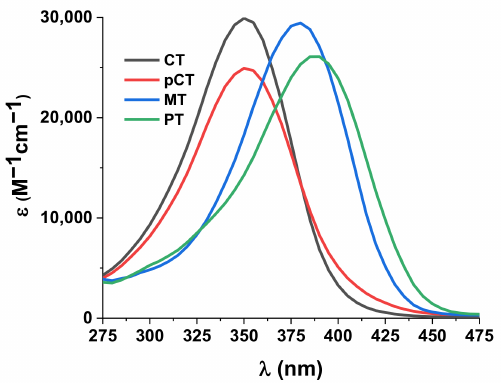
Figure 4. UV − Vis absorption spectra of CT, pCT, MT, and PT in DMF. Table 1. The maximum absorption wavelengths λ max , extinction coefficients ε max at λ max , ε 400 nm at 400 nm, and ε 410 nm at 410 nm of MT, PT, CT, and pCT in DMF.